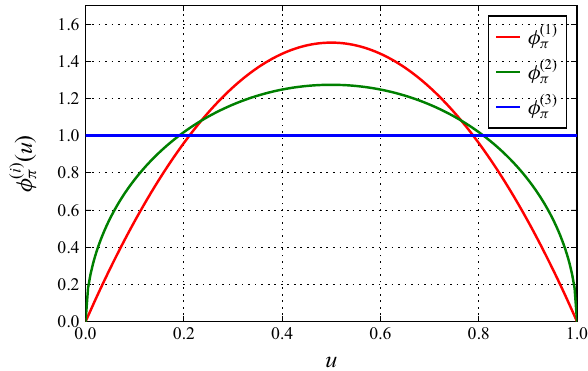
Fig. 1 Plot of the three models for the pion distribution amplitude given in Eq. (6)